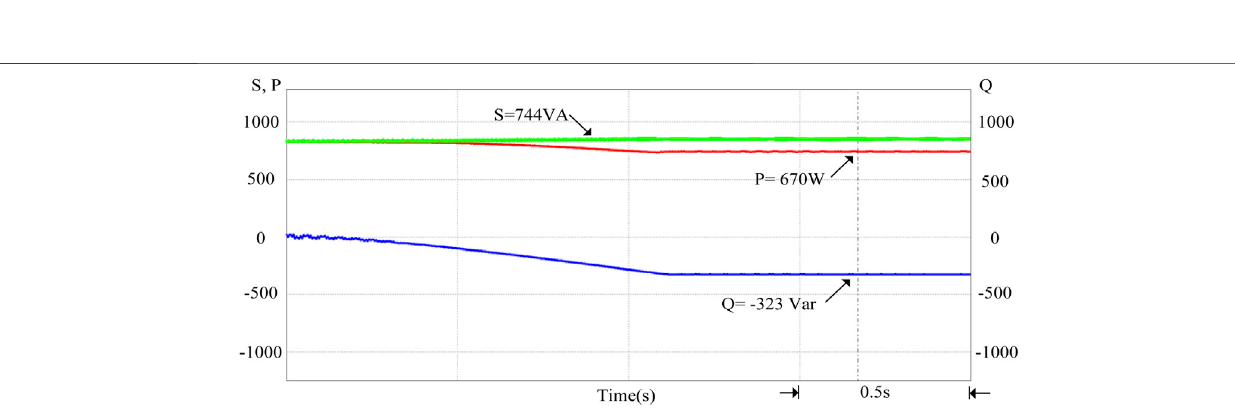
Frontiers in Energy Research |